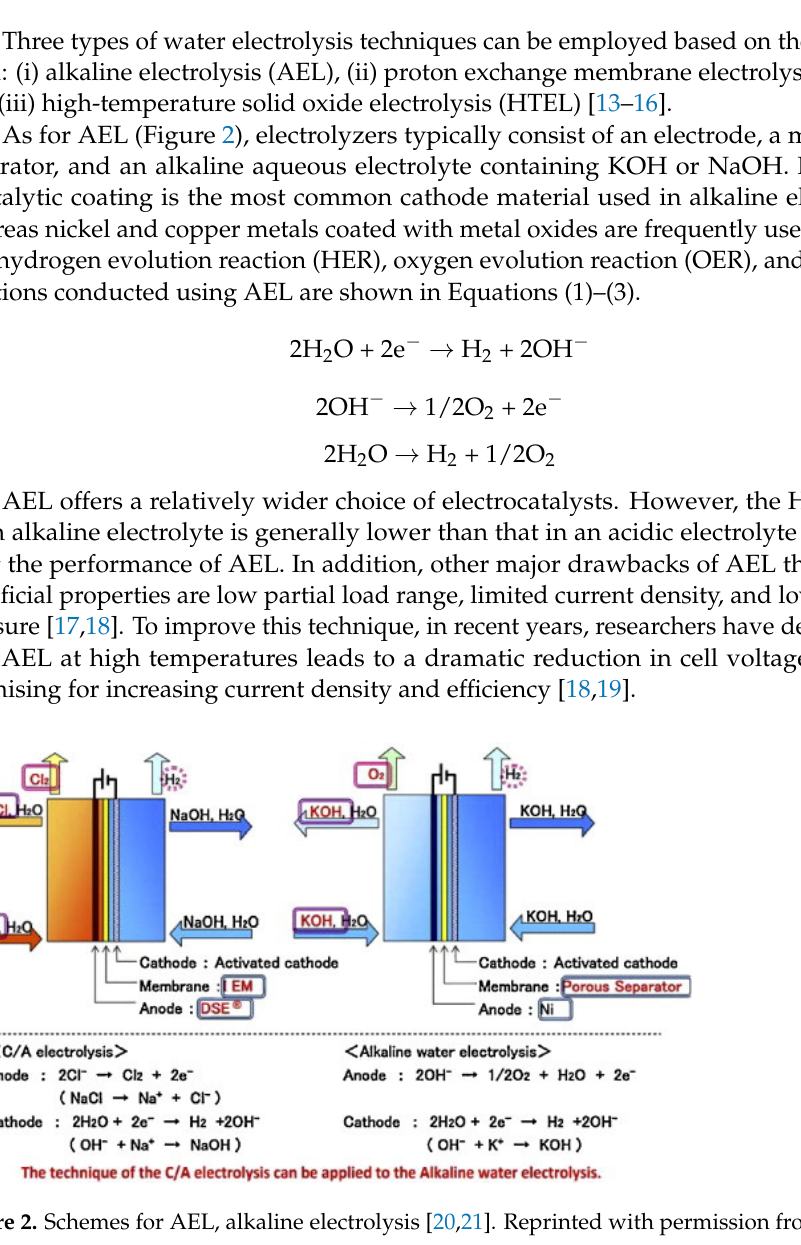
Figure 1. Scheme of a traditional simple electrochemical cell.